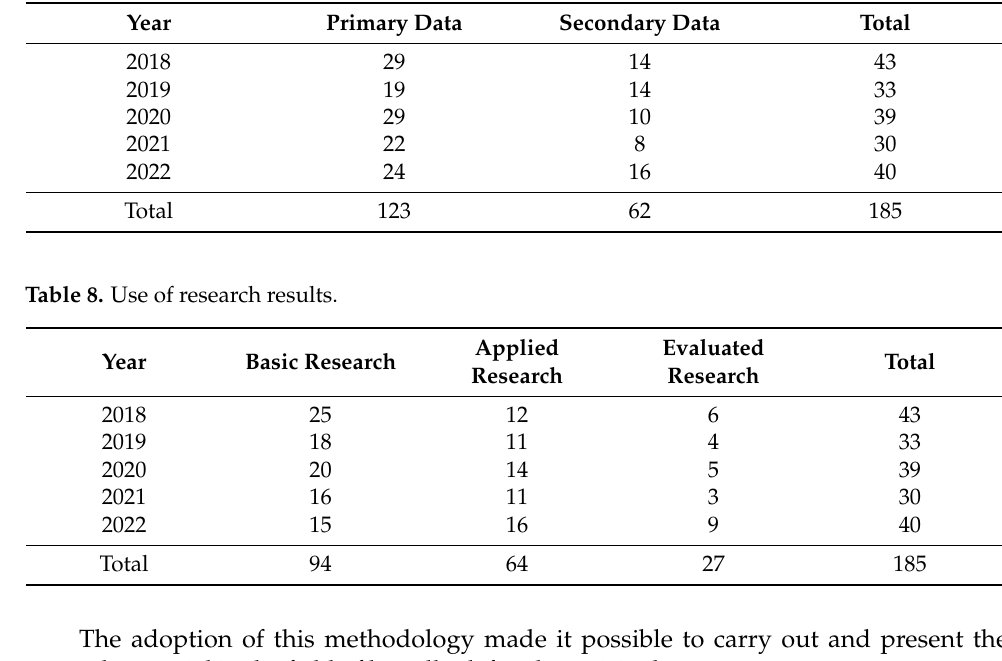
Table 7. Research date collection method.